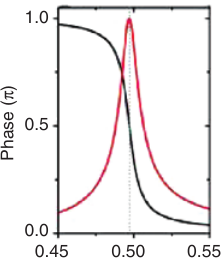
Figure 2: Phase (black) and amplitude (red) responses of a thin dipole nano-antenna. From Ref. [5]. Reprinted with permission from AAAS.